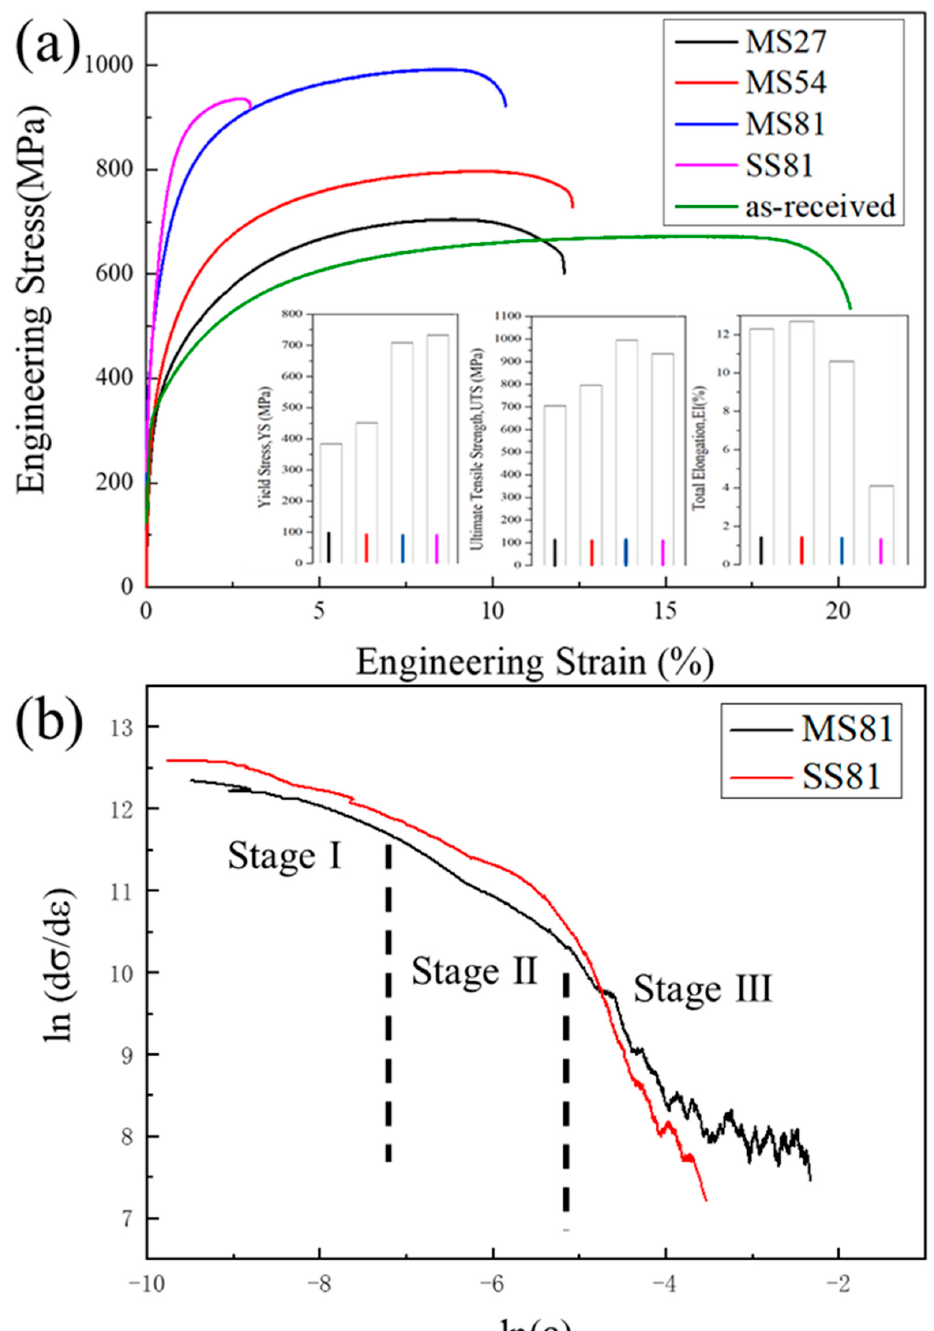
Figure 6. ( a ) Engineering stress–strain curves of MS27, MS54, MS81, and SS81, and ( b ) differential C-J plots of ln(d σ /d ε ) versus ln( ε ) for MS27, MS54, MS81, and SS81.